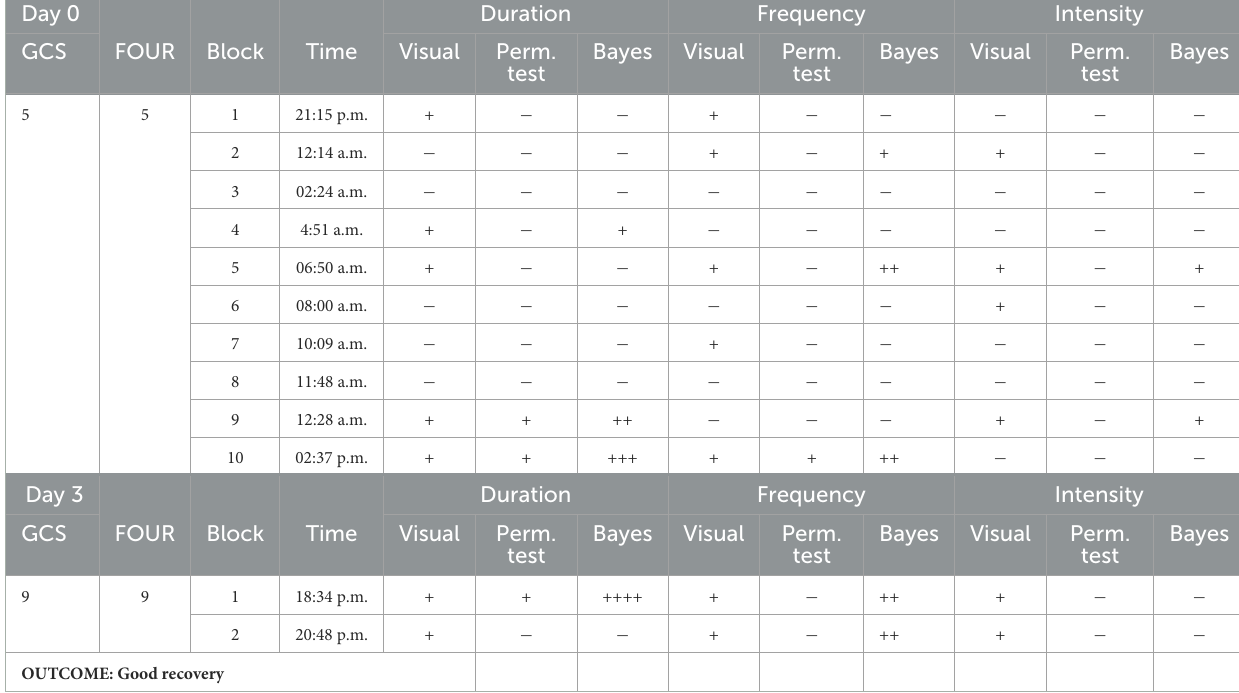
Bayes Visual Perm. Bayes Visual Perm. Bayes test test test